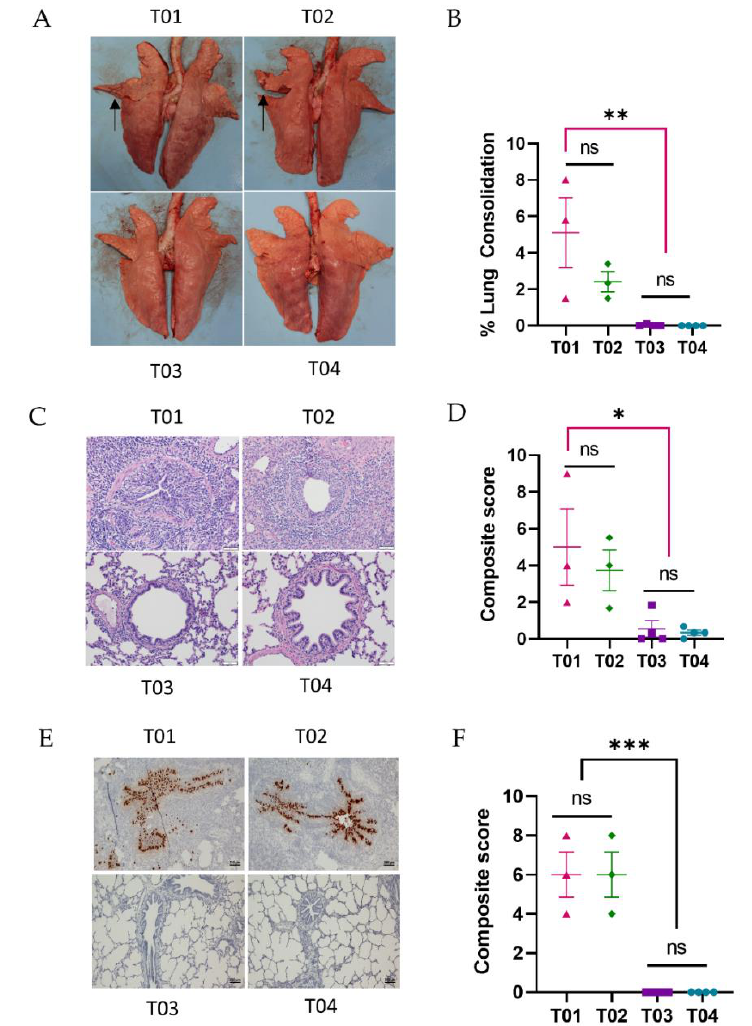
Figure 5. Lung macroscopic and microscopic lesion. ( A ) Representative pictures of pig lungs taken during necropsy. Black arrows indicate lung areas with typical consolidation caused by IAV-S infection. ( B ) Percentage consolidation calculated on a weighted average of each lung lobe. ( C ) Representative images of lung sections stained with H&E to evaluate microscopic lesions. ( D ) Composite microscopic lesion scores based on parameters described previously [22]. Sections from three different lung lobes (apical, middle, and caudal) of each pig were scored, and the average composite score of each pig was used for statistical analysis. ( E ) Representative images of ISH staining for IAV-S NP RNA in lung sections. ( F ) Composite ISH scores based on parameters described in [22]. T01—PBS; T02—rPICV-GFP; T03—rPICV-H3; T04—H3-protein. ns—no significance; * p ≤ 0.05; ** p ≤ 0.01; *** p ≤ 0.001.